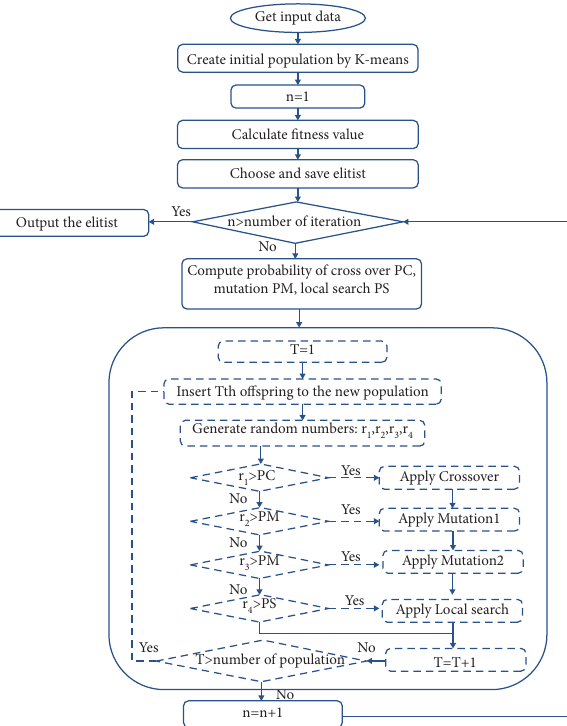
Figure 6: Flowchart of the applied